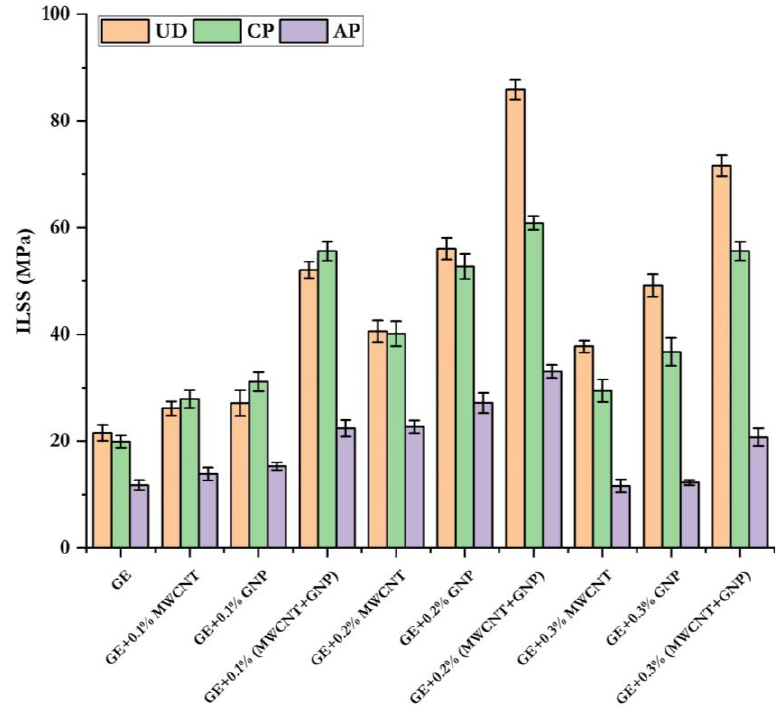
Figure 15. Comparison of ILSS for different laminates. Table 5. ILSS of GE and its nanocomposites.